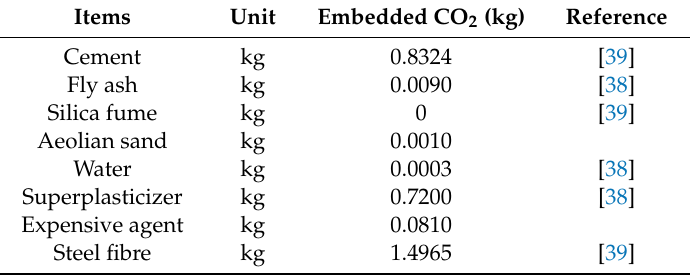
Table 3. Embedded CO 2 of the raw materials of ultra-high-performance concrete (UHPC).